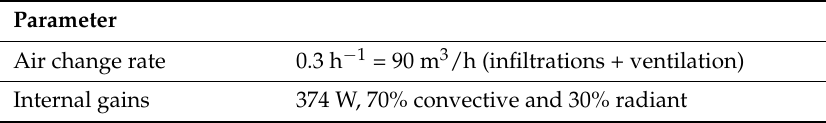
Table 7. Other parameters of the